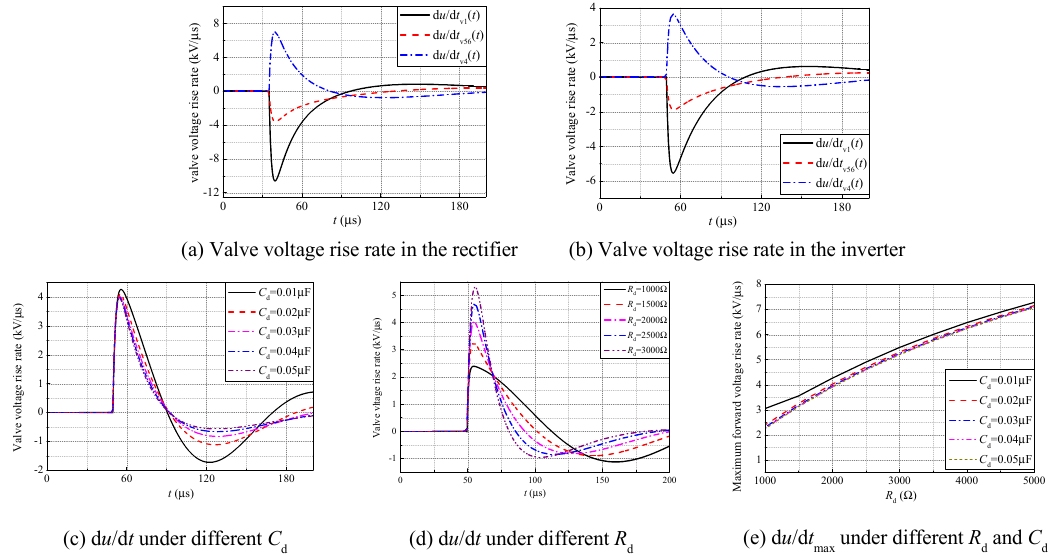
Figure 6. Characteristics of Forward Valve Voltage Rise Rate.